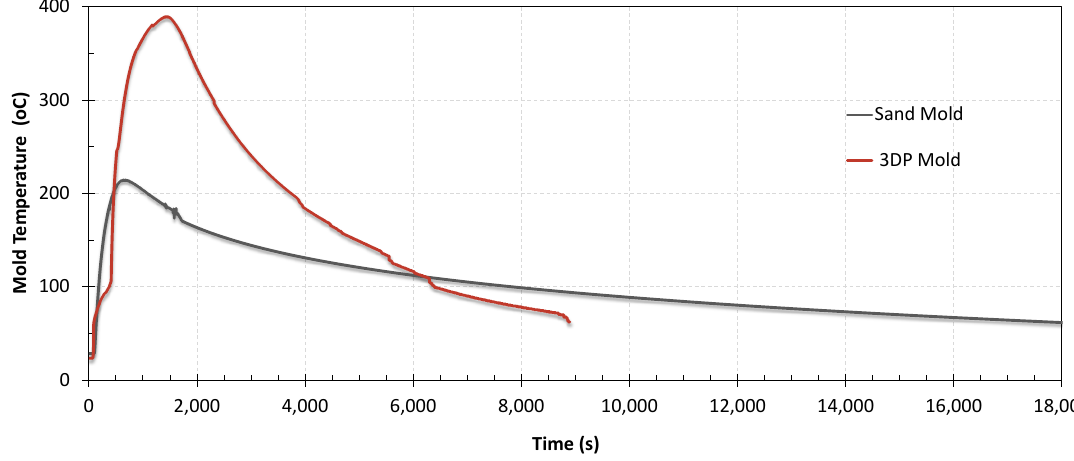
Table 4. Time taken for each manufacturing stage. Figure 9. Temperature profile of the moulds during filling time and cooling time.